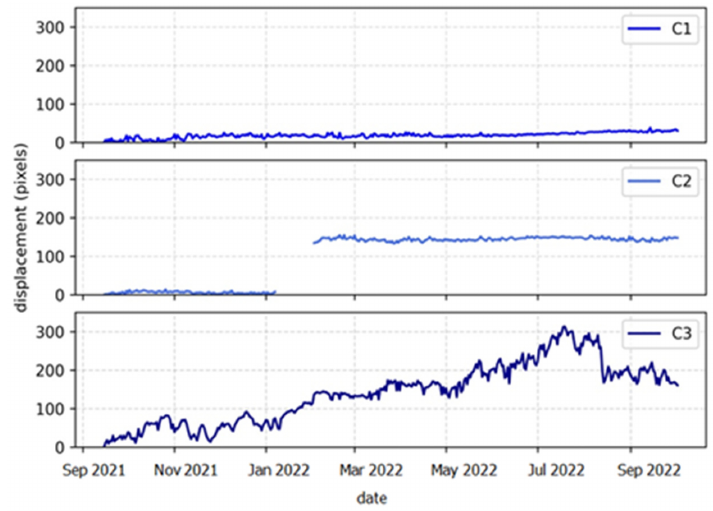
Figure 7. Displacement in pixels of the center of the three cameras from September 2021 to October 2022 regarding the origin position on 15 September 2021. As a result of the cross-correlation process, we obtained images with the disparity between the images taken in different periods (daily, weekly, monthly, etc.) for the three cameras. This allowed us to detect the movement of several columns located in the lower central zone of the study area. One of the objectives of the study was to detect whether precursor movements occurred before the fall. If the answer is yes, we must ask another question related to the frequency of these movements. The tendency is to think that the